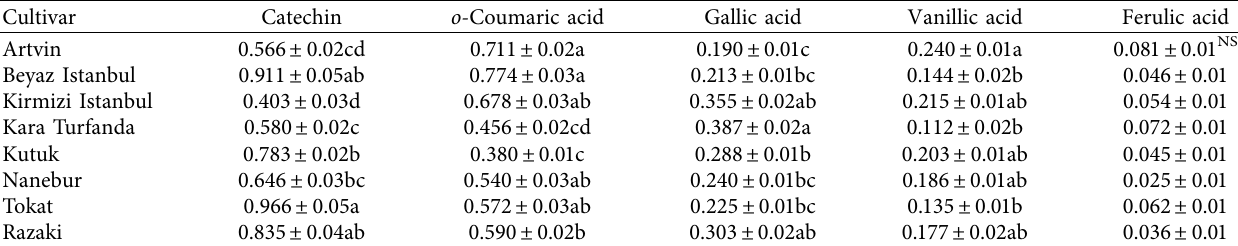
Different letters in the same column indicate statistically significant differences ( p < 0 . 05). Table 3: Minor phenolic compounds in berries of grape cultivars